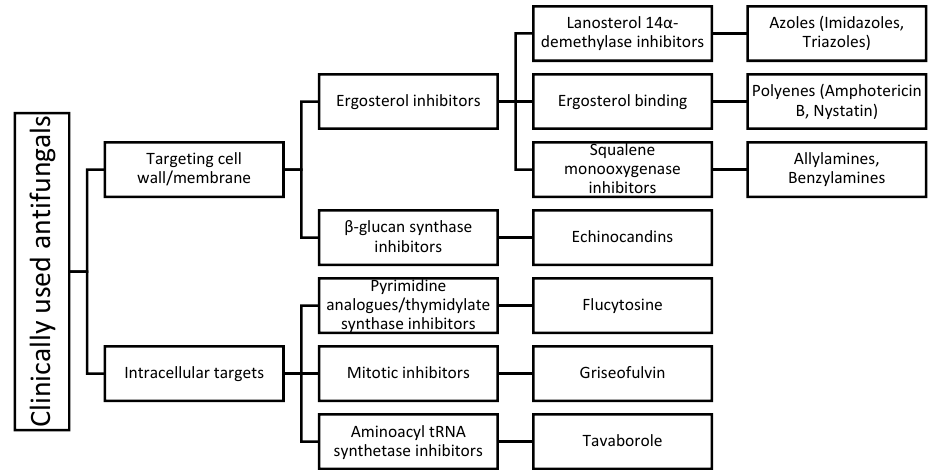
Figure 1. Clinically used antifungals grouped according to their mechanism of action with the most common agents in practice as examples.